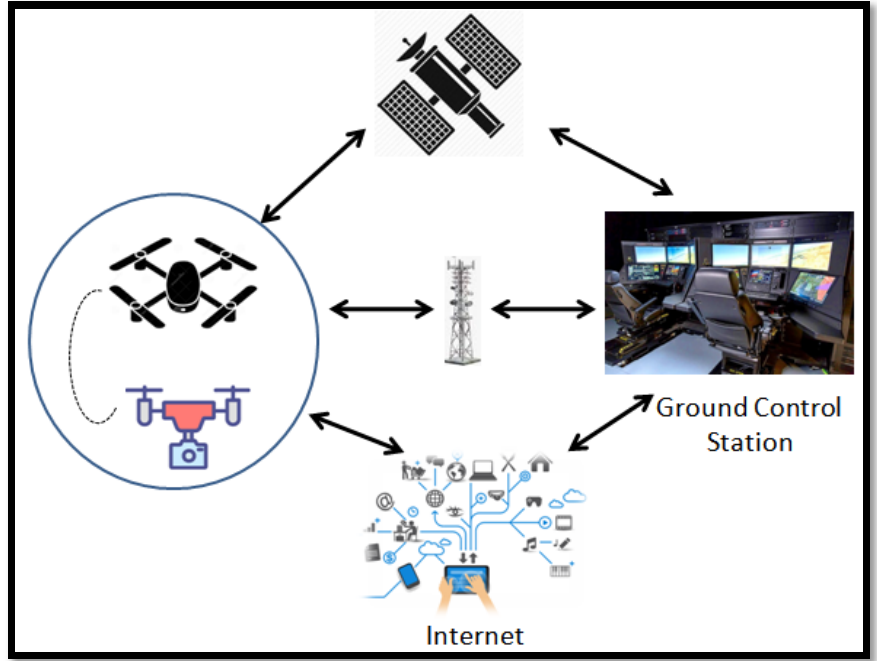
Figure 5. UAVs relaying packets for clients/sensor data to control centers.